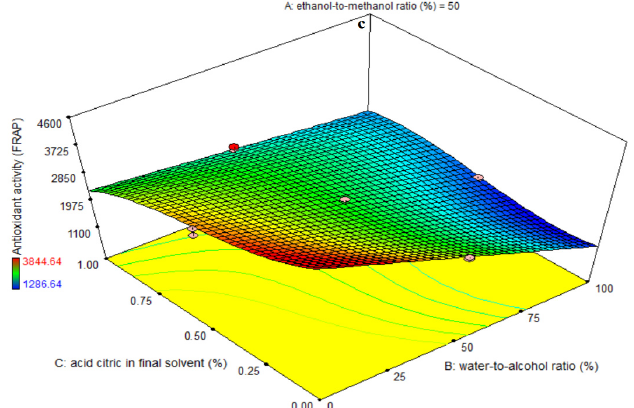
Figure 5. Effects of ethanol-to-methanol ratio (%), water-to-alcohol ratio (%) and citric acid in final solvent (%) on antioxidant activity in terms of ferric reducing antioxidant power (FRAP) assay (µM Fe +2 /g dry extract) in eggplant peel extraction. ( a ): The interaction effect of factors A and B on the intermediate level of factor C., ( b ): The interaction effect of factors A and C on the intermediate level of factor B., and ( c ): The interaction effect of factors B and C on the intermediate level of factor A. Table 6. The analysis of variance (ANOVA) of antioxidant activity in terms of ferric reducing anti- oxidant power (FRAP) assay (third-order fitted polynomial model) in bioactive compounds extrac- tion of eggplant peel by the different solvent combination.